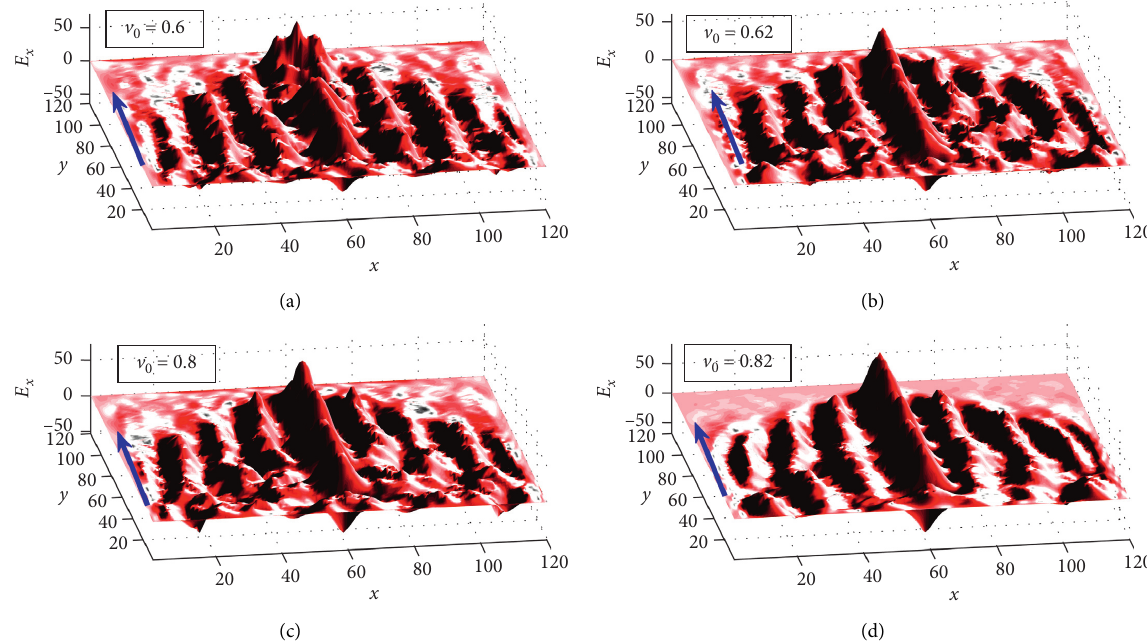
Figure 9: (Color on line) snapshots the field E ε s � 12 . 25 , v enkov wave cone is well defined for all cases